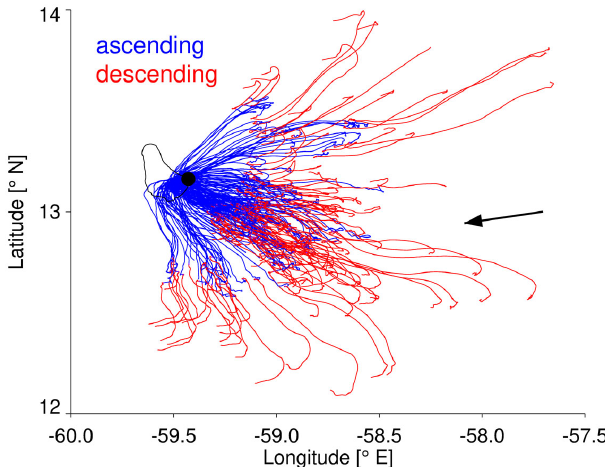
Figure 4. The horizontal trajectories of ascending and descending radiosondes launched from the BCO. The location of the BCO on Barbados is marked by the thick black dot. The black arrow is the mean wind direction at 500m as measurement by ascending sound- ings launched from the